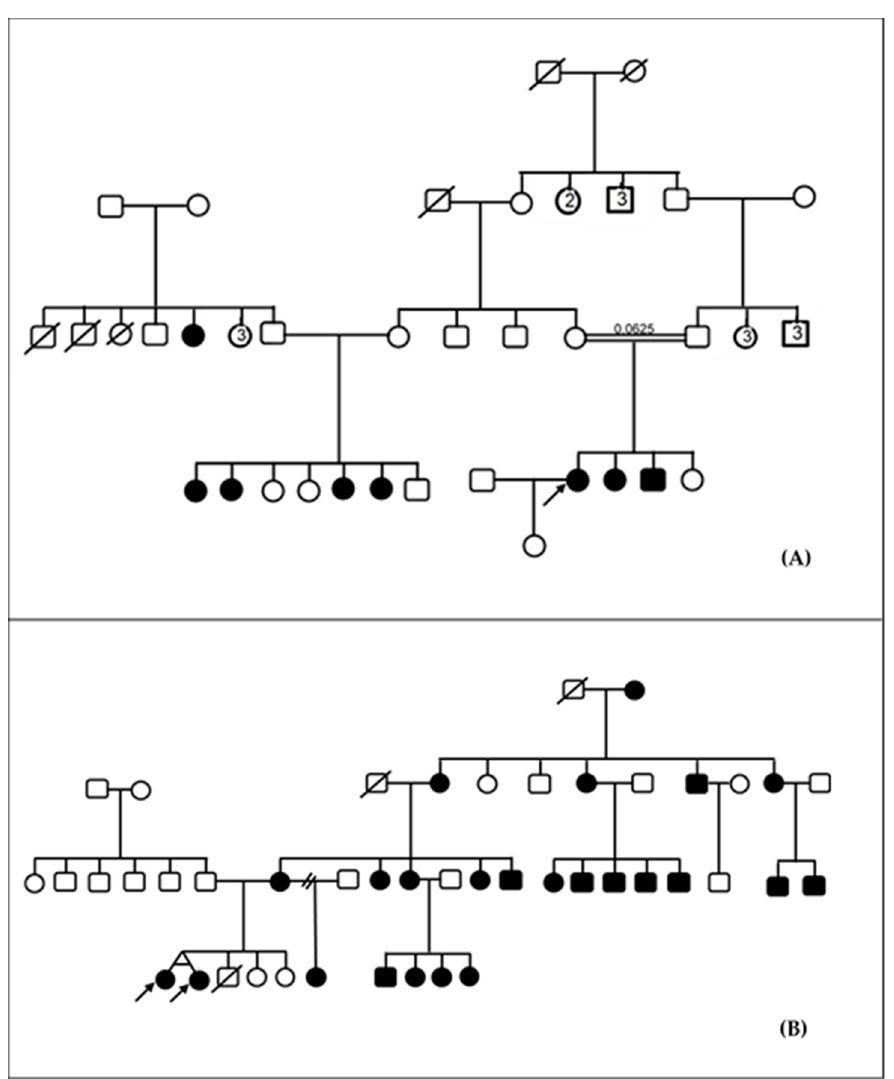
Figure 1. Inheritance of familial hearing impairment in Cameroon. ( A ) Pedigree of a consanguineous family with autosomal recessive non-syndromic hearing impairment. ( B ) Pedigree of a family with non-syndromic hearing impairment suggestive of mitochondrial inheritance. Arrows here indicate the probands.